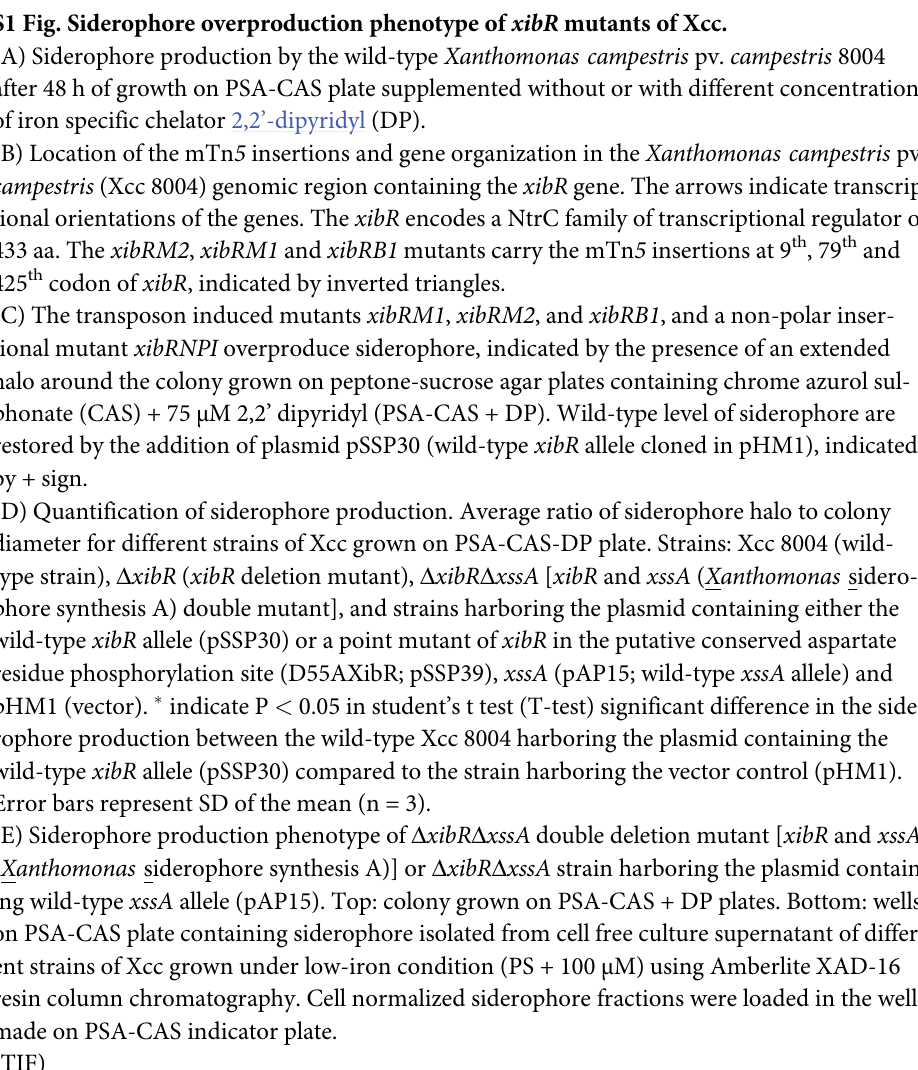
S1 Fig. Siderophore overproduction phenotype of xibR mutants of